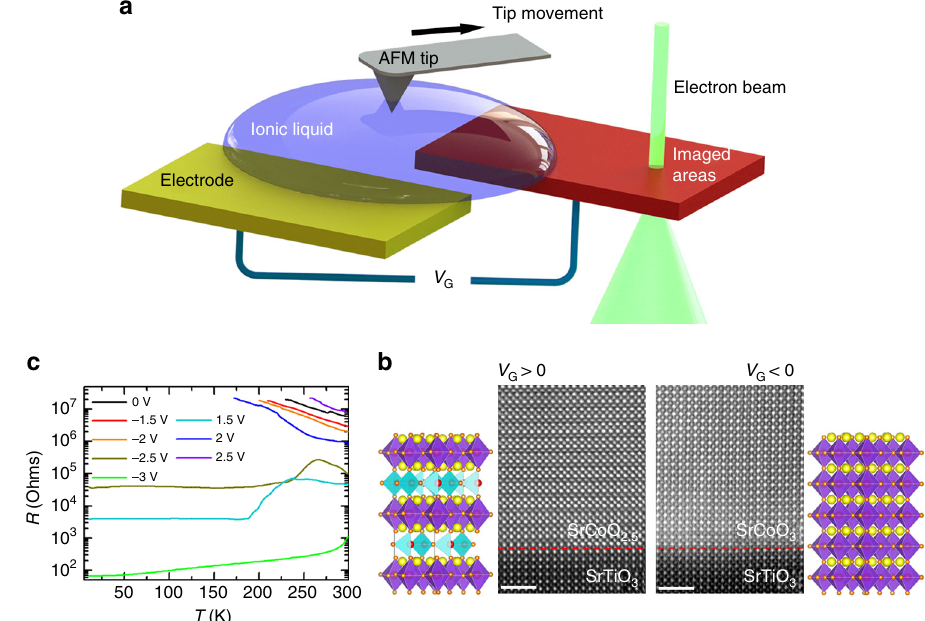
Fig. 1 Ionic liquid gating effect for SrCoO x . a Schematic drawing of in situ TEM measurement setup with ionic liquid placement by an atomic force microscope tip. Positive and negative gate voltages V G are applied to the ionic liquid by the gate electrode. b Typical STEM-HAADF images are shown for the as-deposited fi lm SrCoO 2.5 and the same fi lm after gating with V G = – 3 V for 15min. The white scale bar corresponds to 2 nm. The yellow, red, and orange spheres denote Sr, Co, and O, respectively. c Resistance versus temperature curves at various V G as indicated in the fi gure for a 40nm thick SrCoO 2.5 fi